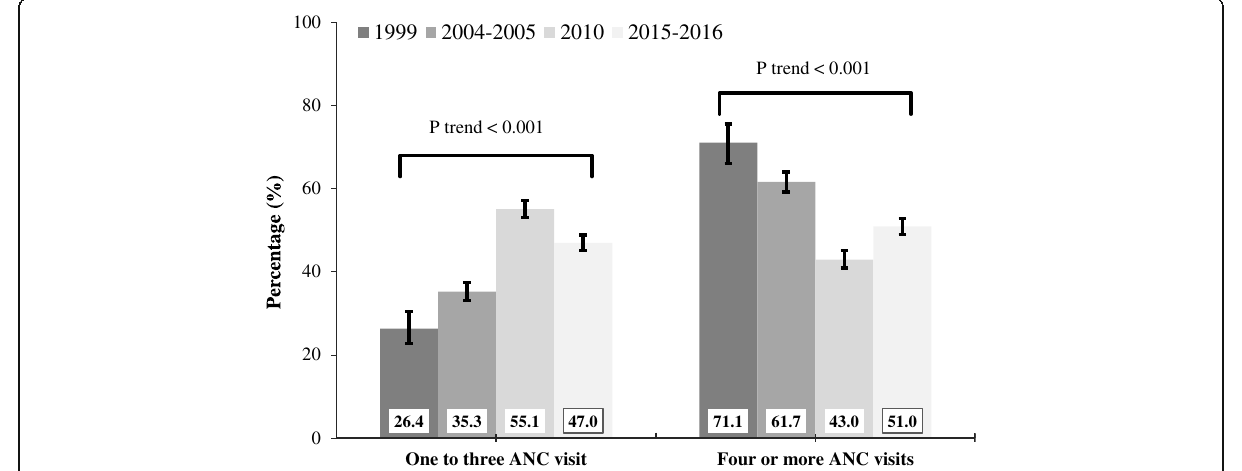
Fig. 2 Trends in antenatal care service use in Tanzania, 1999 to 2016. Error bars indicate 95% confidence